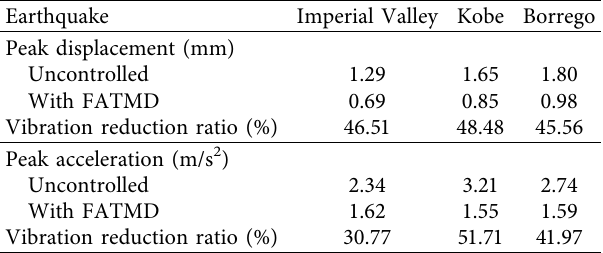
Table 5: Dynamic responses in the midspan of the bridge with and without the